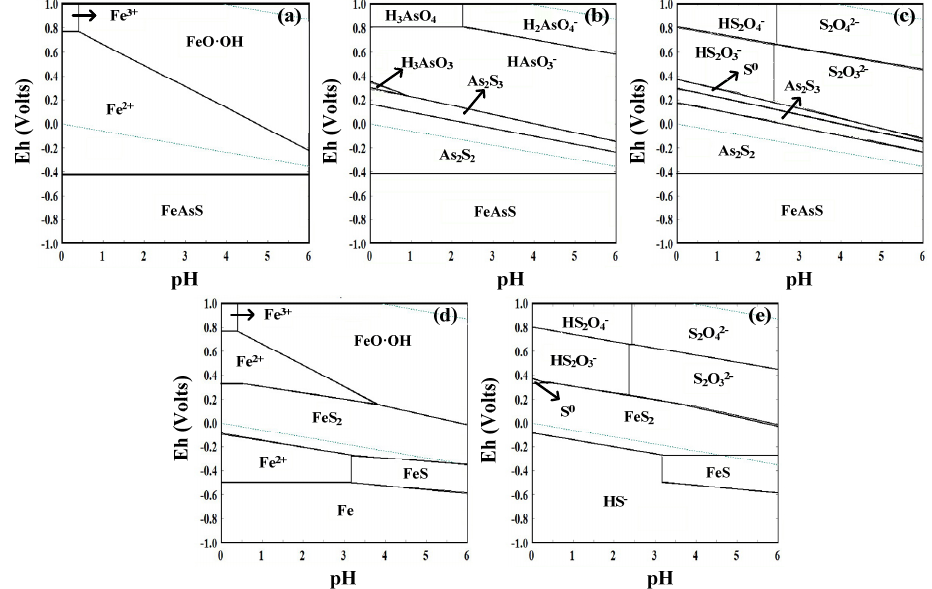
Figure 5. Eh–pH diagrams of Fe-As-S-H 2 O systems: ( a ) Fe species; ( b ) As species; ( c ) S species and Fe-S-H 2 O systems: ( d ) Fe species; ( e ) S species. Conditions: [Fe 2 + ] total 0.16 M, [FeAsS] 7.4 × 10 − 4 mM, [FeS 2 ] 3 × 10 − 4 mM; 25 °C and 1 atm.